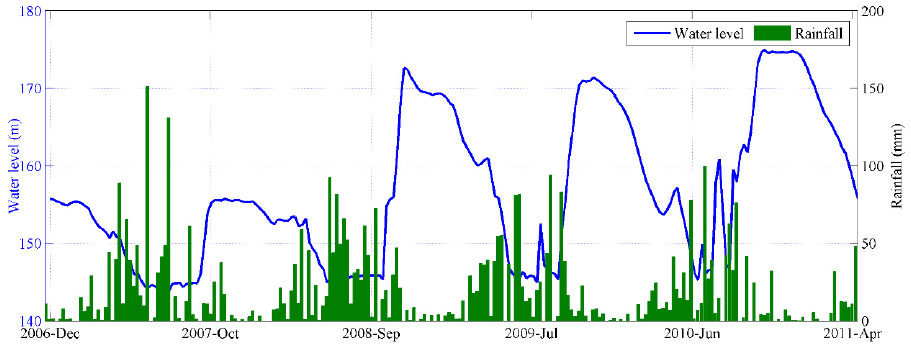
Figure 2. Water levels of upstream Yangtze River and weekly cumulative rainfall in Fengjie from 2007 to 2011.